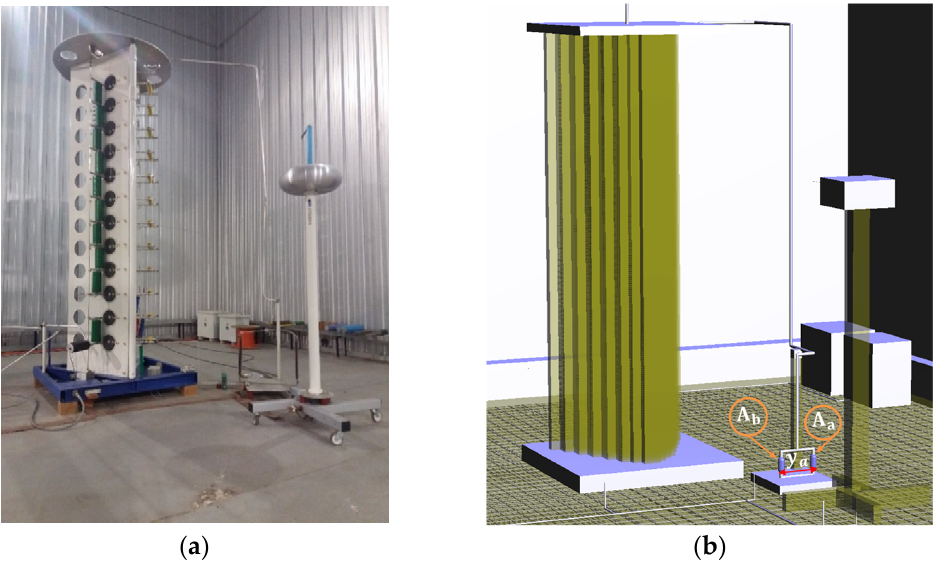
Figure 8. Laboratorial setup for performing residual voltage measurements on 440 V voltage-class surge arresters: ( a ) real-world setup and ( b ) depiction of part of the corresponding SAGS FDTD- 3D model.